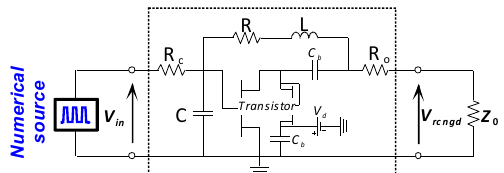
Figure 16: Schematics of the RCNGD-circuit including the biasing network using an FET = PHEMT ATF-34143 ( V 0V, V = 3V, I = 110 mA), for R d d